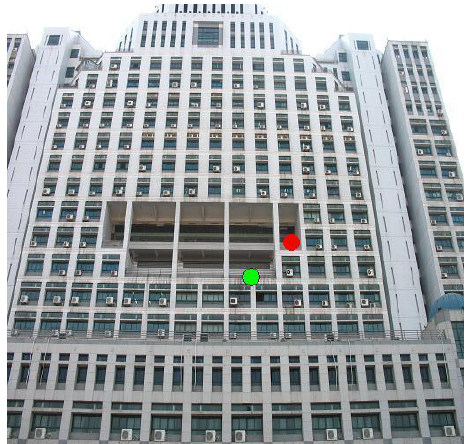
Figure 7c: The estimated viewpoint and its actual